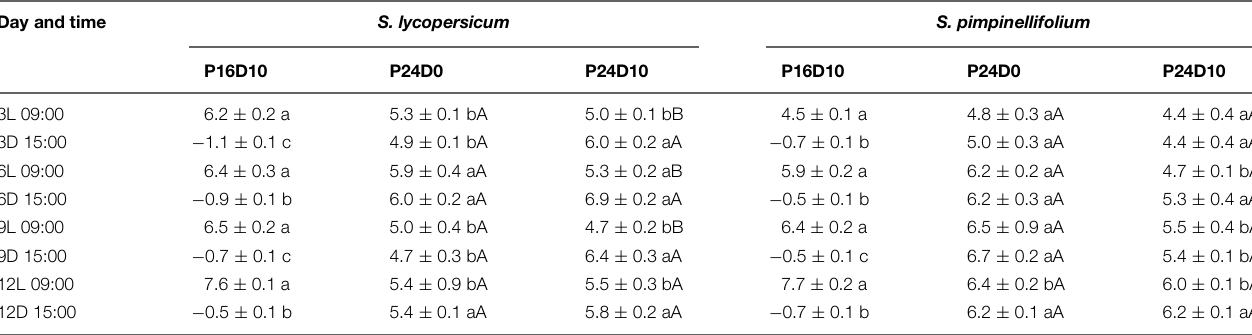
TABLE 2 | The rate of leaf photosynthesis (P N , µ mol CO 2 m − 2 s − 1 ) in Solanum lycopersicum and S. pimpinellifolium grown in three photoperiod treatments (P16D10, P24D0, and P24D10) where P gives the hours of light and D gives the difference in temperature between light and